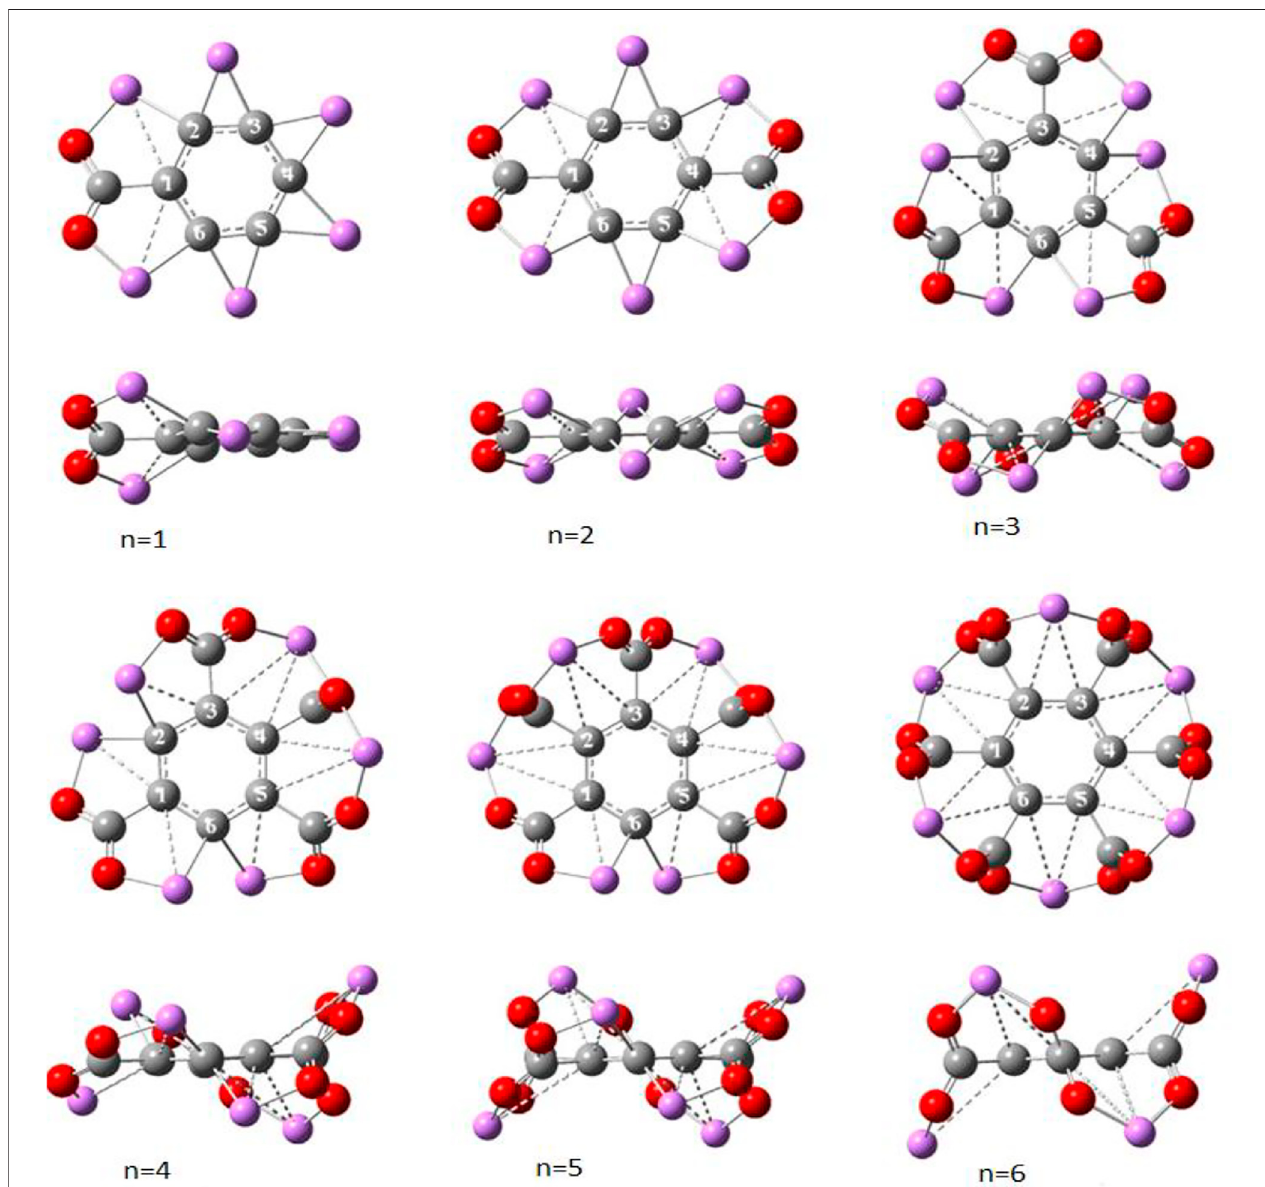
FIGURE 10 | Optimized structure of C 6 Li 6 - n CO 2 complexes (front and side views) for n = 1 – 6 from Ref. 63 with the permission of Wiley.